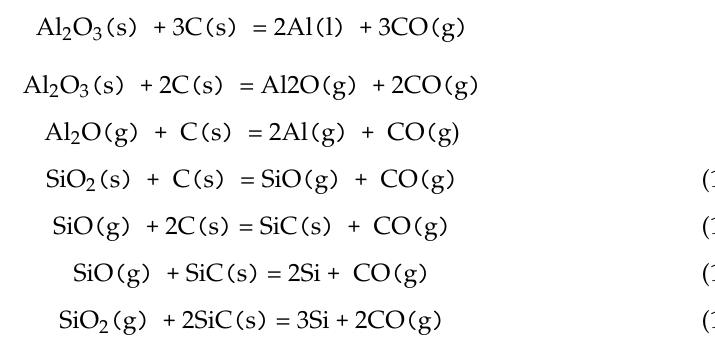
Figure 8. SEM micrograph and EDS spectra of the cross-sectioned pellet (C/O = 1.5) after heating at 1550 °C for 3 h. Figure 9. SEM micrograph and EDS spectra of the cross-sectioned pellet (C/O = 2) after heating at 1550 °C for 3 h.